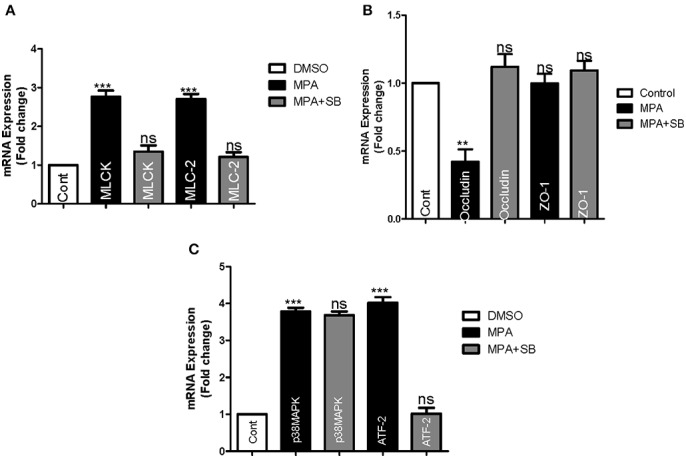
p38MAPK inhibition preserves normal MLCK/MLC-2 gene expression in Caco2 cells treated with MPA. Bar graphs showing the mRNA expression levels of MLCK and MLC-2
(A), occludin and ZO-1
(B), and p38MAPK and ATF-2
(C) in either presence or absence of p38MAPK inhibitor. Values are expressed as means ± SEM. Asterisk indicates the significance (**P < 0.01, ***P < 0.001) when compared to control cells. Differences between two groups were analyzed by the two-tailed Student's t-test and of more than two groups by One-way ANOVA with Bonferroni posttest. ns, non-significant.